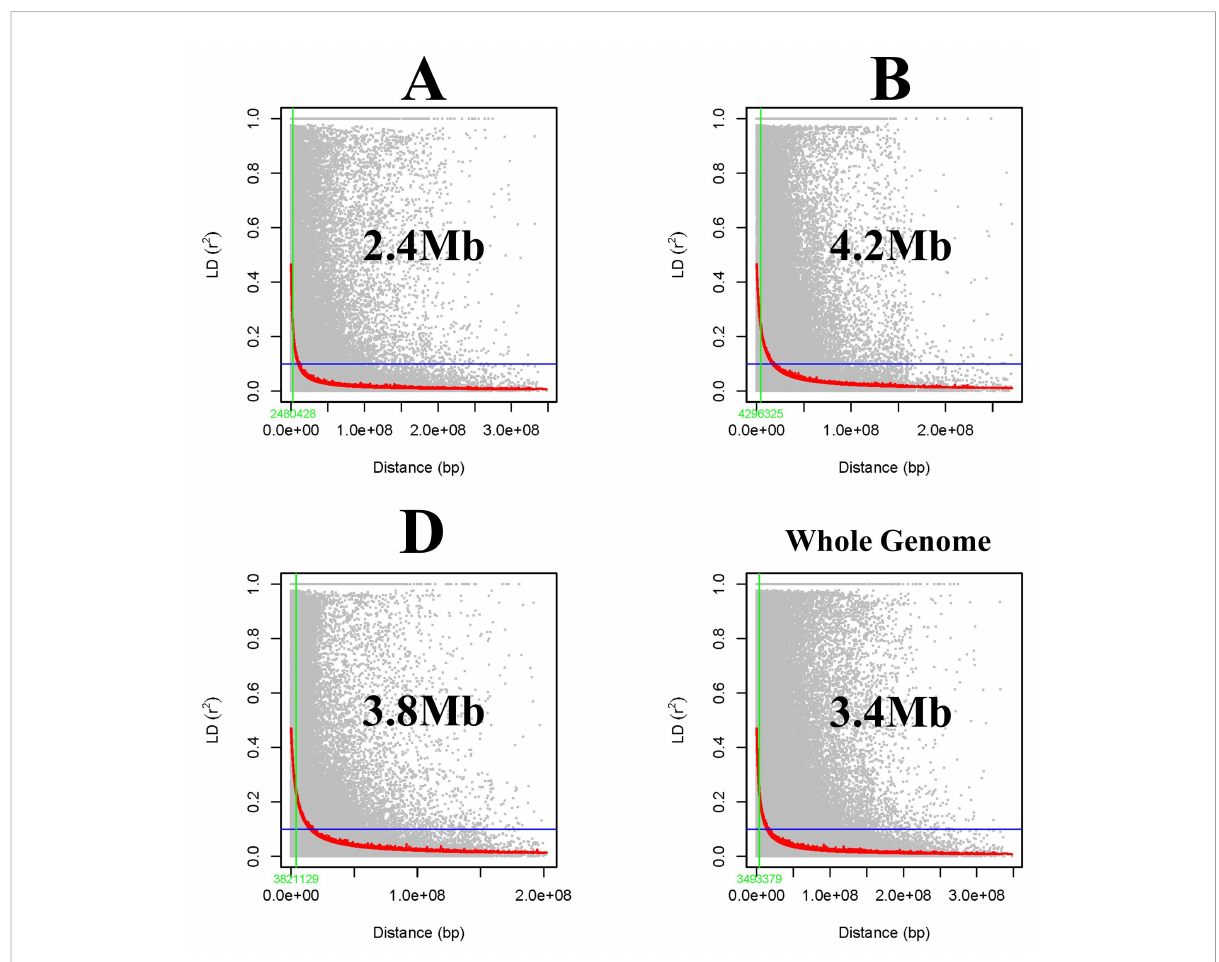
FIGURE 6 Subgenome (A, B, D) and whole-genome-wide linkage disequilibrium (LD) decay in the GWAS